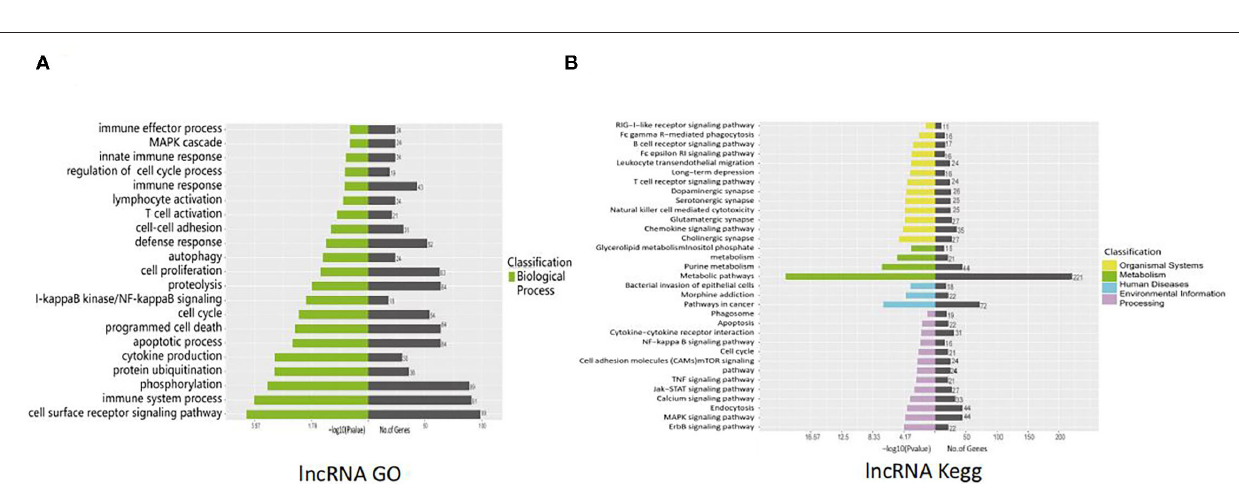
FIGURE 3 | Functional prediction of SVV-induced annotated lncRNAs. (A) Gene Ontology (GO) analysis of the functional annotation of differentially expressed annotated lncRNAs. (B) KEGG pathway analysis of the functional annotation of differentially expressed annotated lncRNAs. cancer. Processing included apoptosis, p53 signaling pathway, cytokine–cytokine receptor interaction, NF-kappa B signaling pathway, cell cycle, cell adhesion molecules (CAMs), mTOR signaling pathway, TNF signaling pathway, JAK-STAT signaling pathway, endocytosis, and MAPK signaling